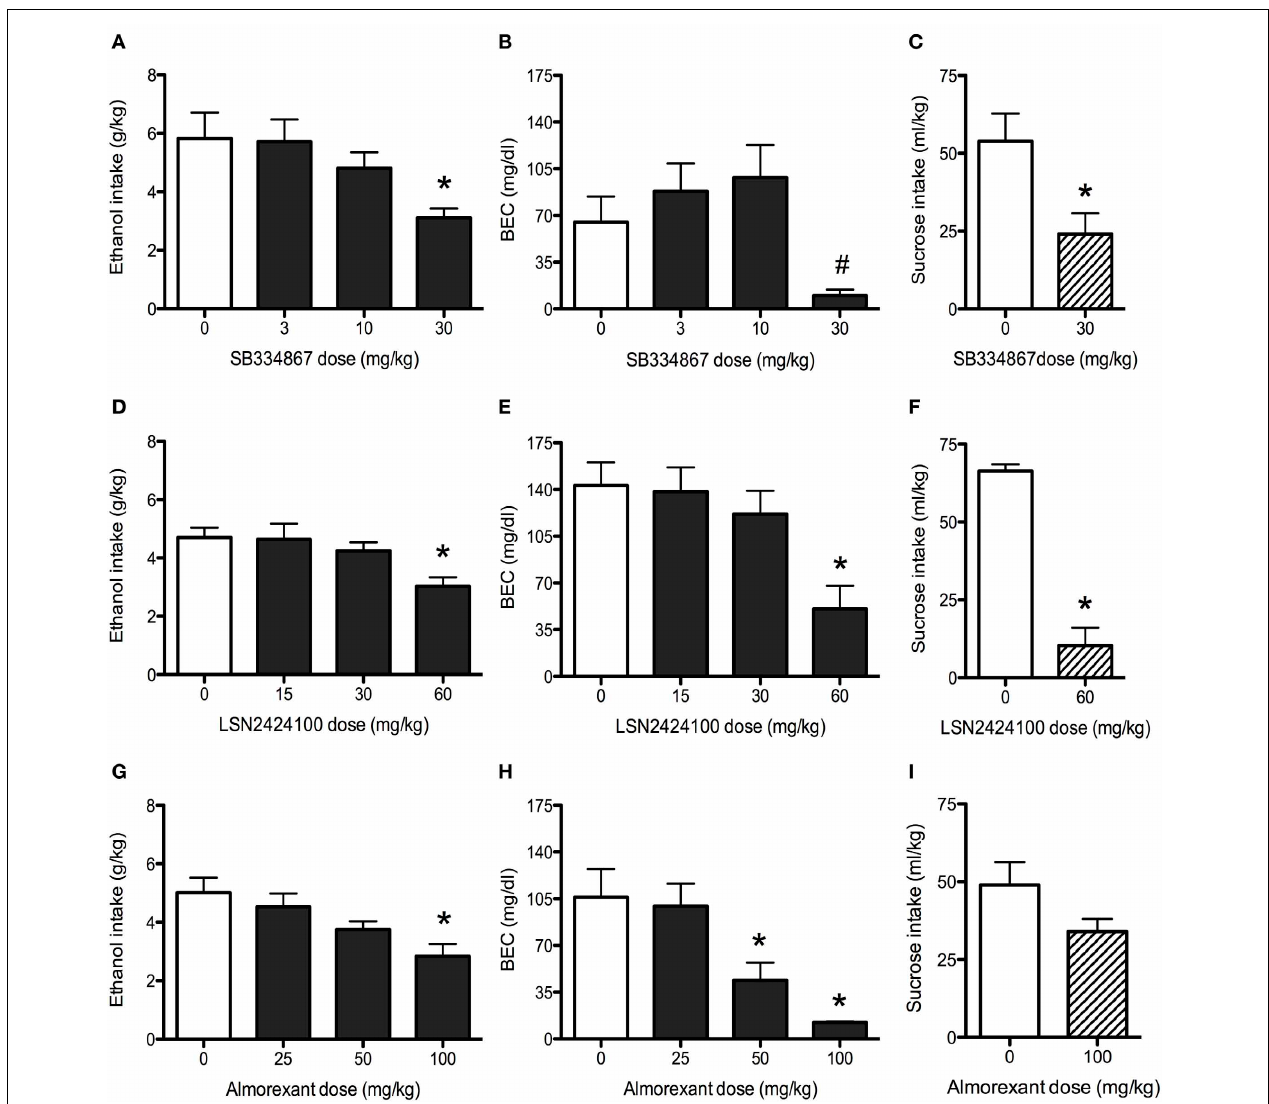
FIGURE 3 | Binge drinking in C57BL/6J mice. (A) SB334867 ( n = 10) reduced ethanol consumption at the 30mg/kg dose. (B) The 30mg/kg dose of SB334867 resulted in lower BECs relative to both the 10 and 30mg/kg doses (indicated by #, p < 0 . 05). (C) In a separate cohort of mice, SB334867 (30mg/kg) also reduced consumption of a 1% sucrose solution ( n = 6–7). (D) LSN2424100 ( n = 10) reduced ethanol consumption at the 60mg/kg dose. (E) The same dose resulted in lower BECs relative to vehicle-injected controls.